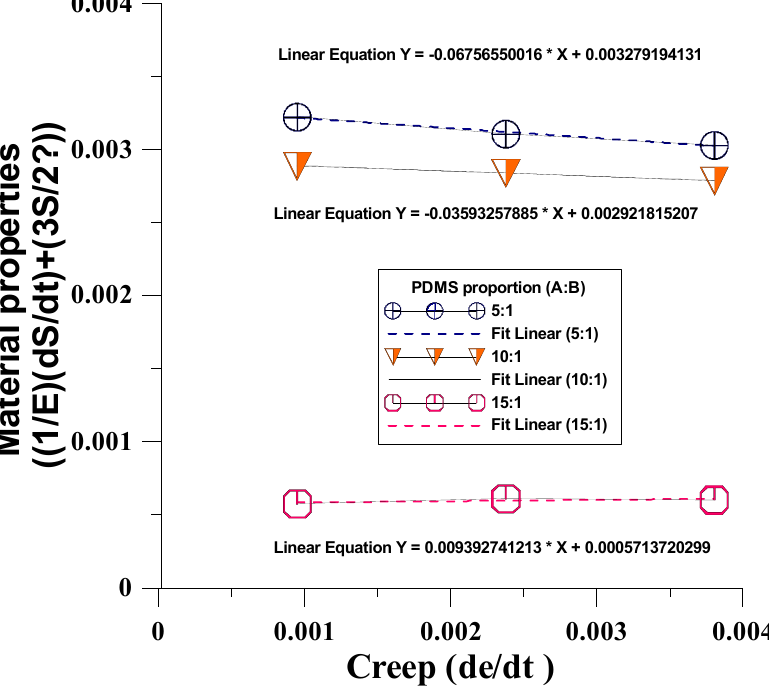
Figure 12. Time-dependent creep behavior of the dependent variables in the dynamic tensile process of Model B.